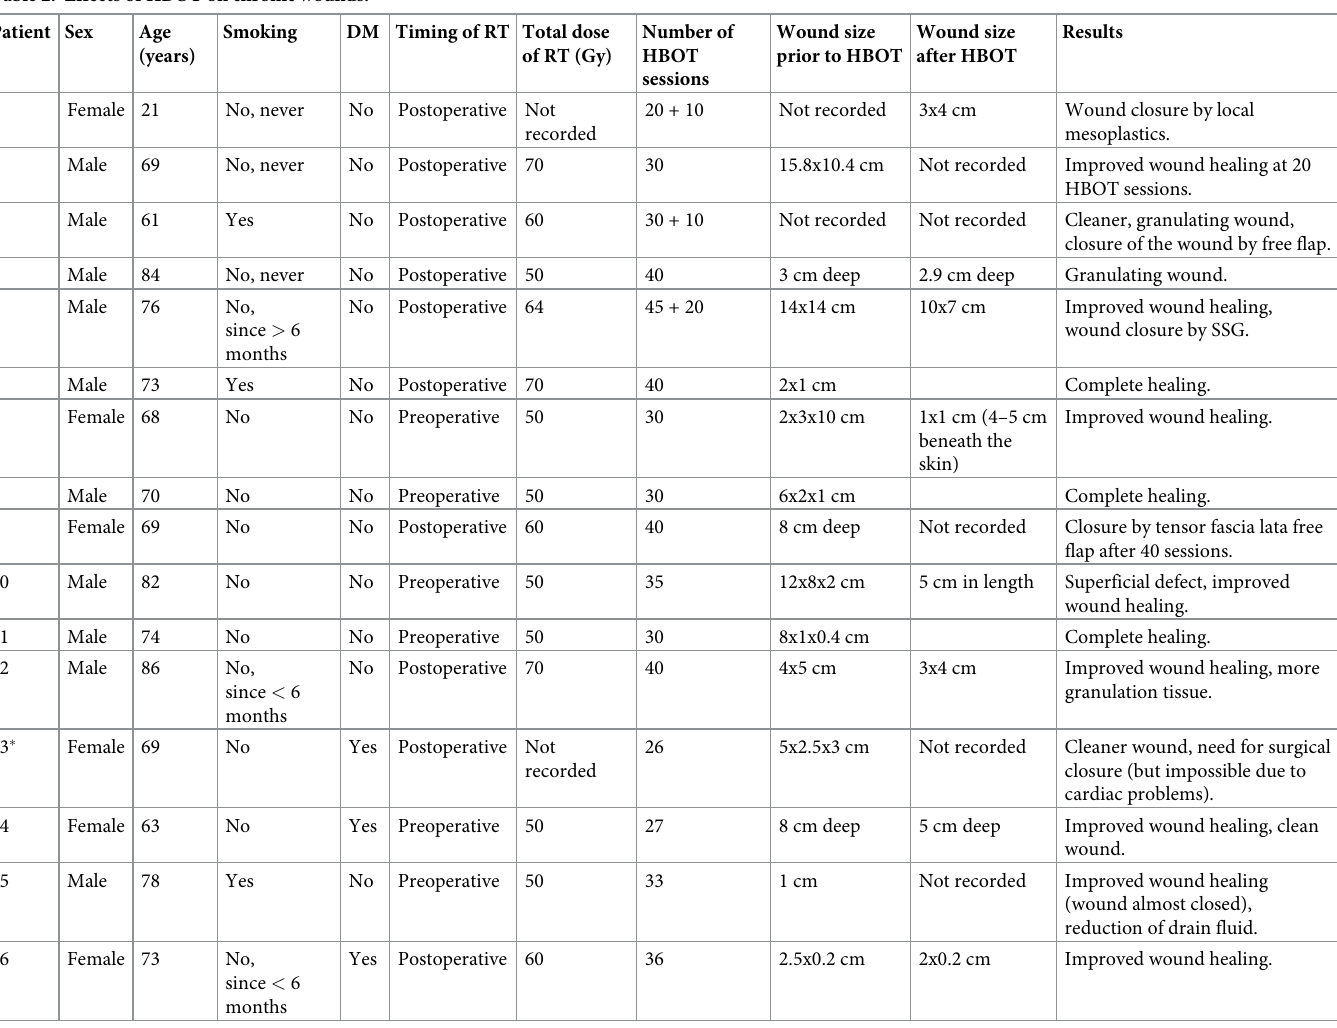
Table 2. Effects of HBOT on chronic